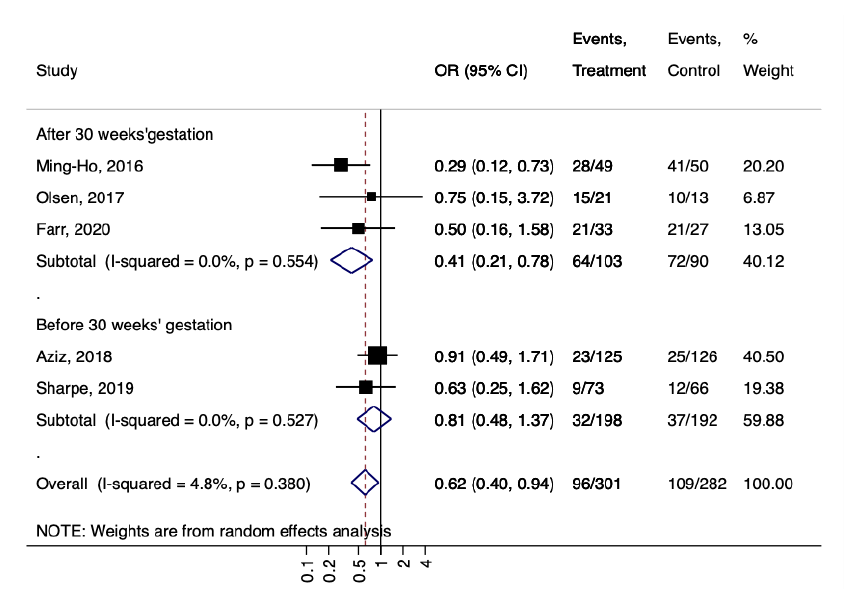
Figure 5. Forest plot for the GBS colonization according to the gestational age at beginning of the treatment with probiotics (after 30 weeks or before 30 weeks). Ming-Ho, 2016 [32], Olsen, 2017 [33], The duration of the treatment (less or more than 12 weeks) did not seem to alter the effect on GBS colonization because the stratified group showed positive trends toward the protective effect of probiotics (Figure 6).